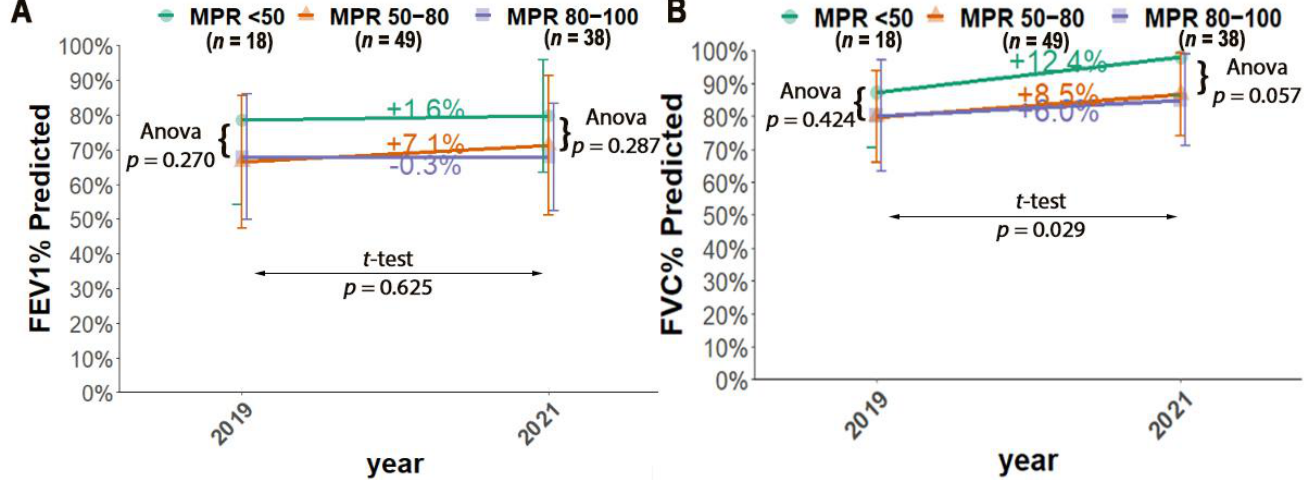
Figure 5. Lung function, FEV 1 (panel ( A )) and FVC (panel ( B )) over time by MPR category for begin and end year of the study (MPR < 50% (2019; n = 10, 2021; n = 8), MPR 50 – 80% (2019; n = 24, 2021; n n = 25), MPR 80–100% (2019; n = 17, 2021; n = 21). The type of test conducted and the p -value obtained = 25), MPR 80 – 100% (2019; n = 17, 2021; n = 21) . The type of test conducted and the p -value obtained are indicated between are indicated between arrows.